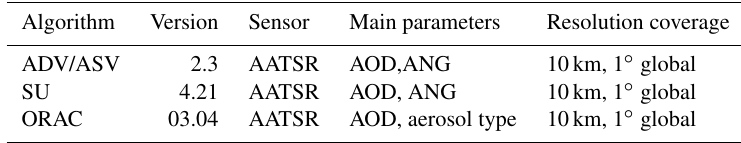
Figure 1. The distribution of selected AERONET and CARSNET sites in mainland China in 2007, 2008, and 2010. The blue and red points represent AERONET and CARNET sites, respectively. Table 1. Details of AATSR AOD products.